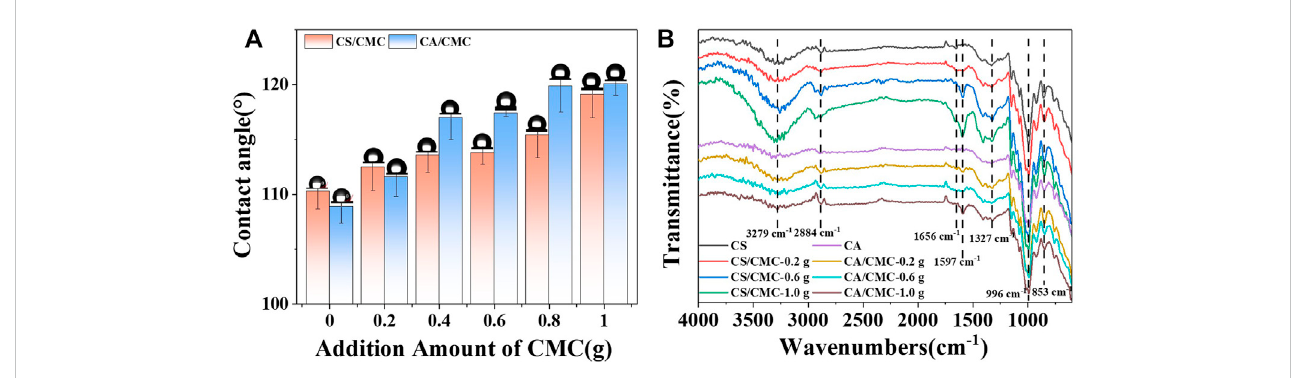
The contact angle and FTIR spectra of the starch/CMC composite fi lms. (A) : the contact angle; (B) : FTIR